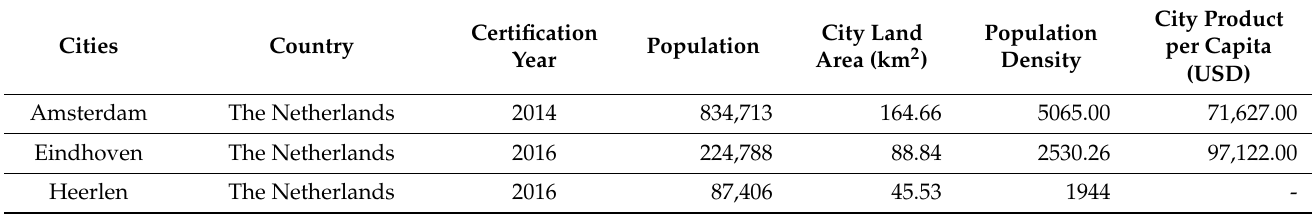
Table 3. The selected cities